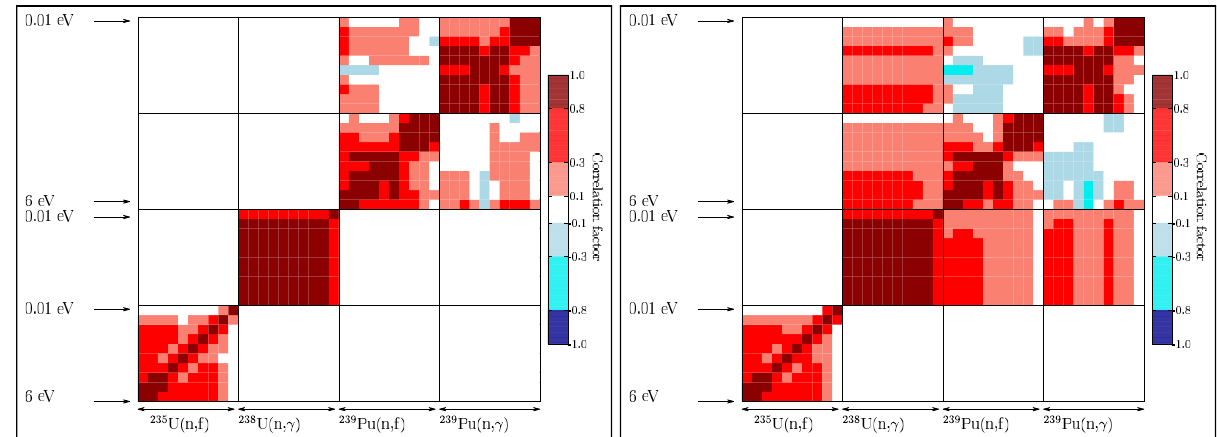
Fig. 2. Case of correlations between various actinide cross sections. Left: prior correlation matrix without PIE data; right: posterior correlation matrix using the PIE measurement from 239